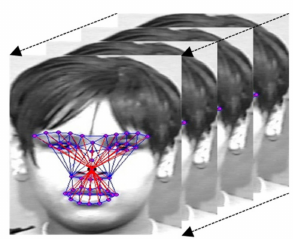
Figure 3. Depicting master nodes on a human face in a frame sequence. The nose node is considered a master node, then all nodes are connected to it. In this figure, the red edges are built on the basis of the master node, and the blue ones are built according to normal graph